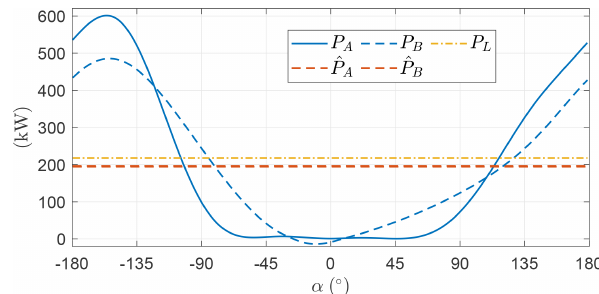
Figure 28. Optimal electrical power production as a function of the angular position.